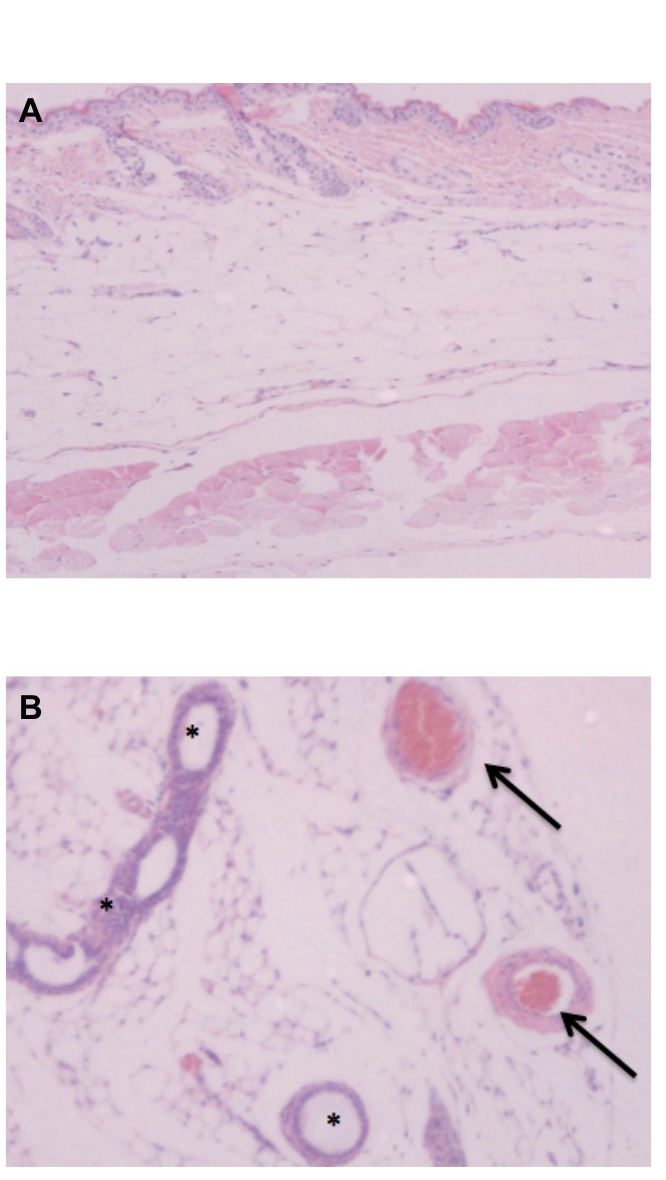
FIGURE 3 - Photomicrographies of week 9 of the experiment. A ) Absence of PPM. B ) Loose conjunctive tissue presenting congested vessels (arrow) and sweat duct (asterisk). HE stains. Zoom: 10x ( A ) and 40x ( B ). PPM: porcine peritoneum membrane